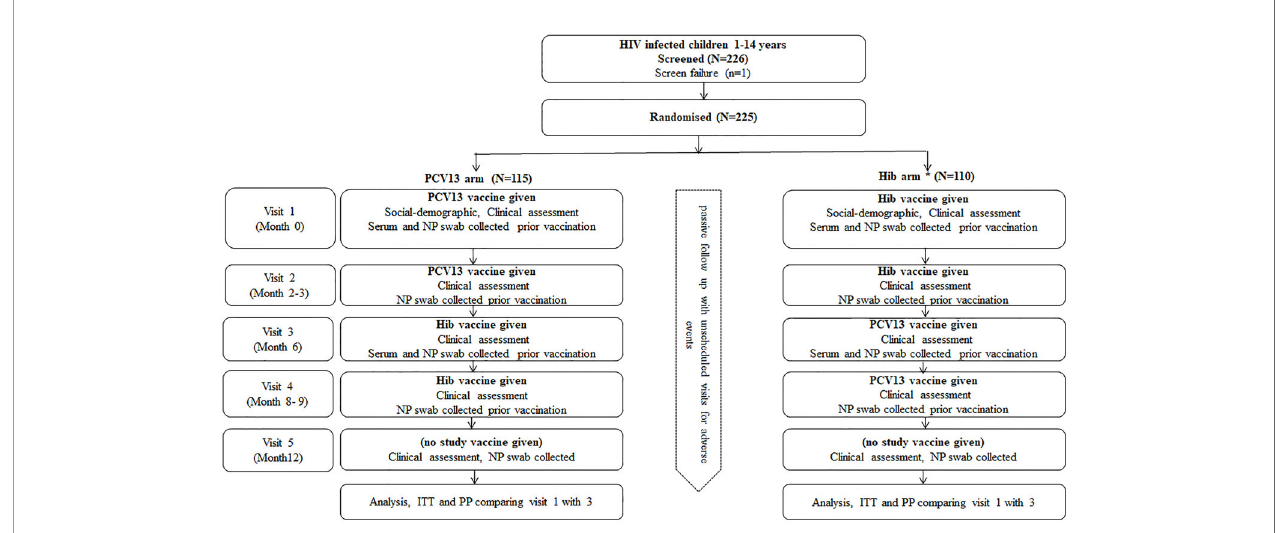
FIGURE 1 | Study design fl ow chart. A single dose of Hib vaccine was given if there was evidence that the child had received three doses of Hib vaccine previously, HIV, Human immunode fi ciency virus; PCV13, 13 valent Pneumococcal Conjugated Vaccine; Hib, Haemophilus in fl uenza type b; NP, Nasopharyngeal; ITT, Intention to treat; PP, per